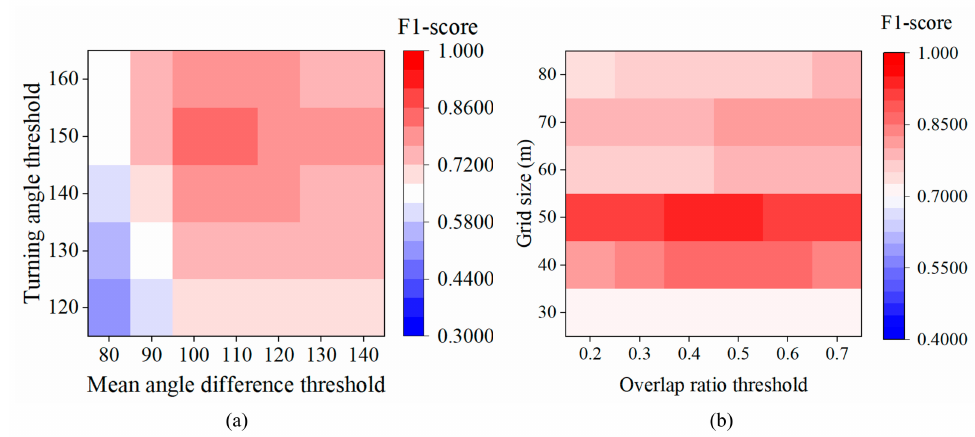
Figure 9. Accuracy of suspicious behavior detection with varying parameters from the TucityLife dataset. ( a ) aimlessly wandering; ( b )